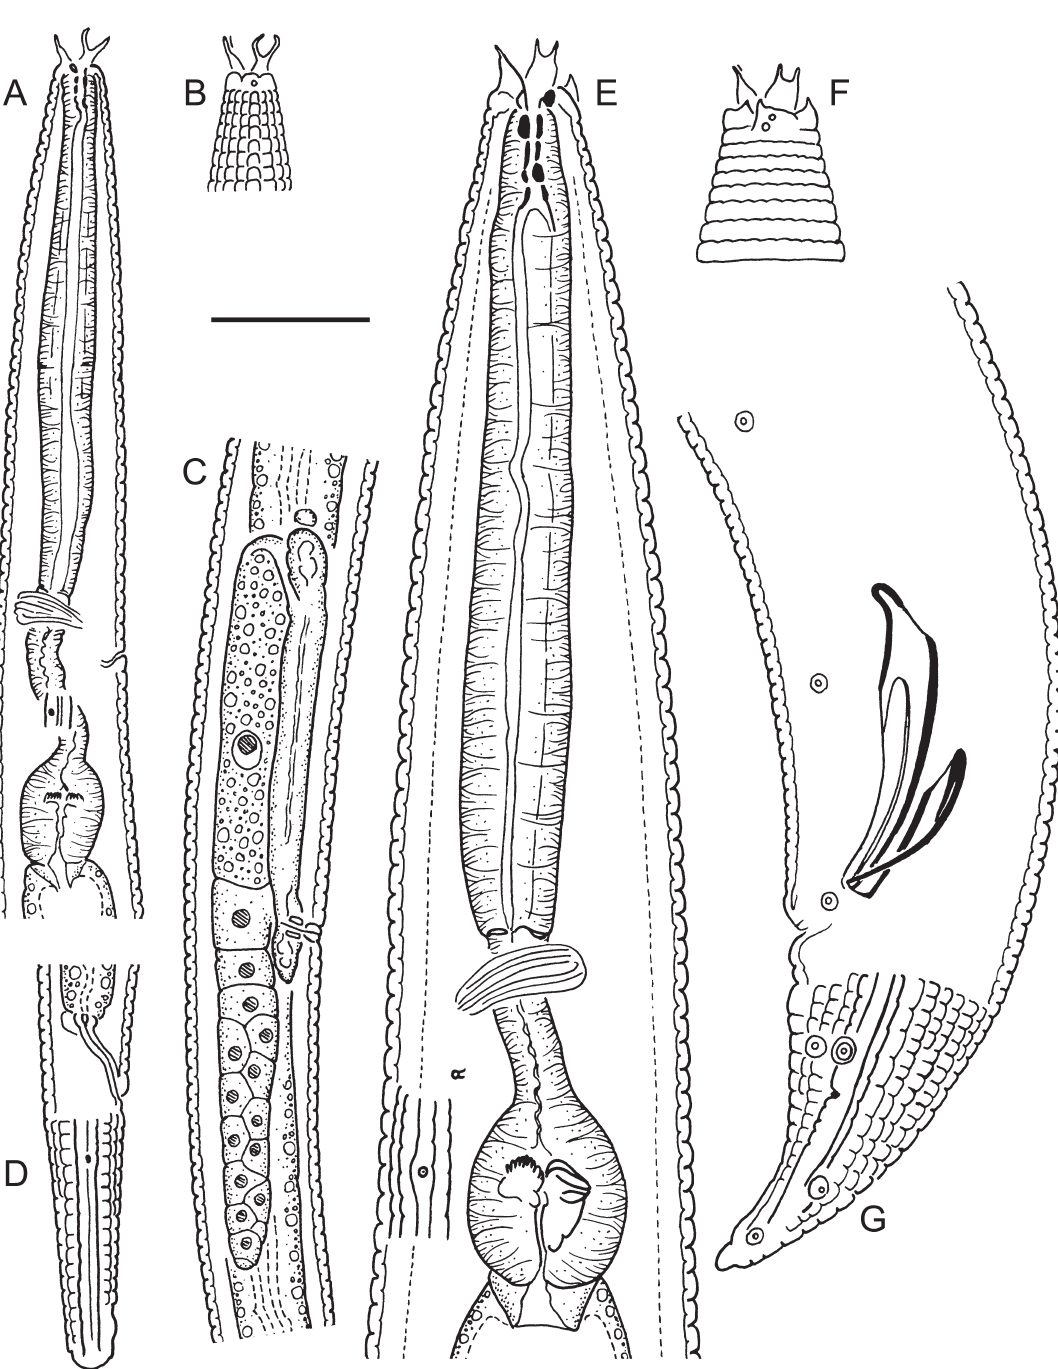
Fig. 4. A–D . Stegelleta ophioglossa Andrássy, 1967. A . Pharyngeal region. B . Anterior end, surface view. C . Female gonad. D . Female tail. E–G . Stegelleta tuarua Yeates, 1967. E . Pharyngeal region. F . Anterior end, surface view. G . Male tail. Scale bar = 20